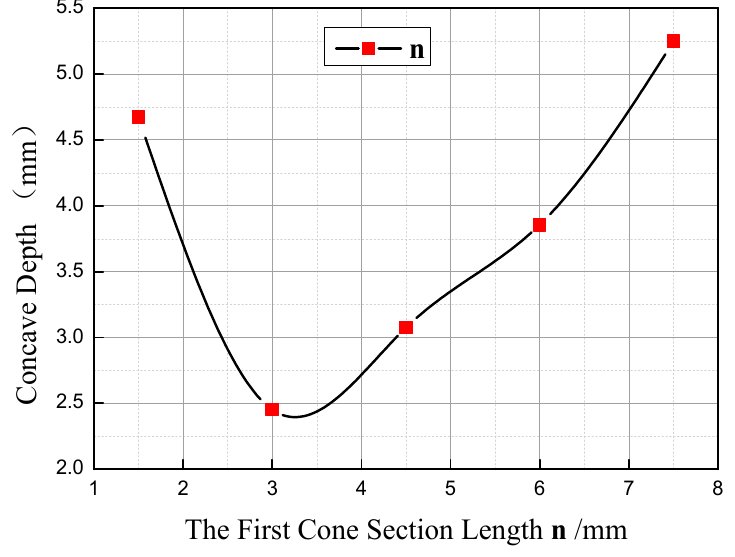
Figure 12. Influence of the first cone section length n on concave